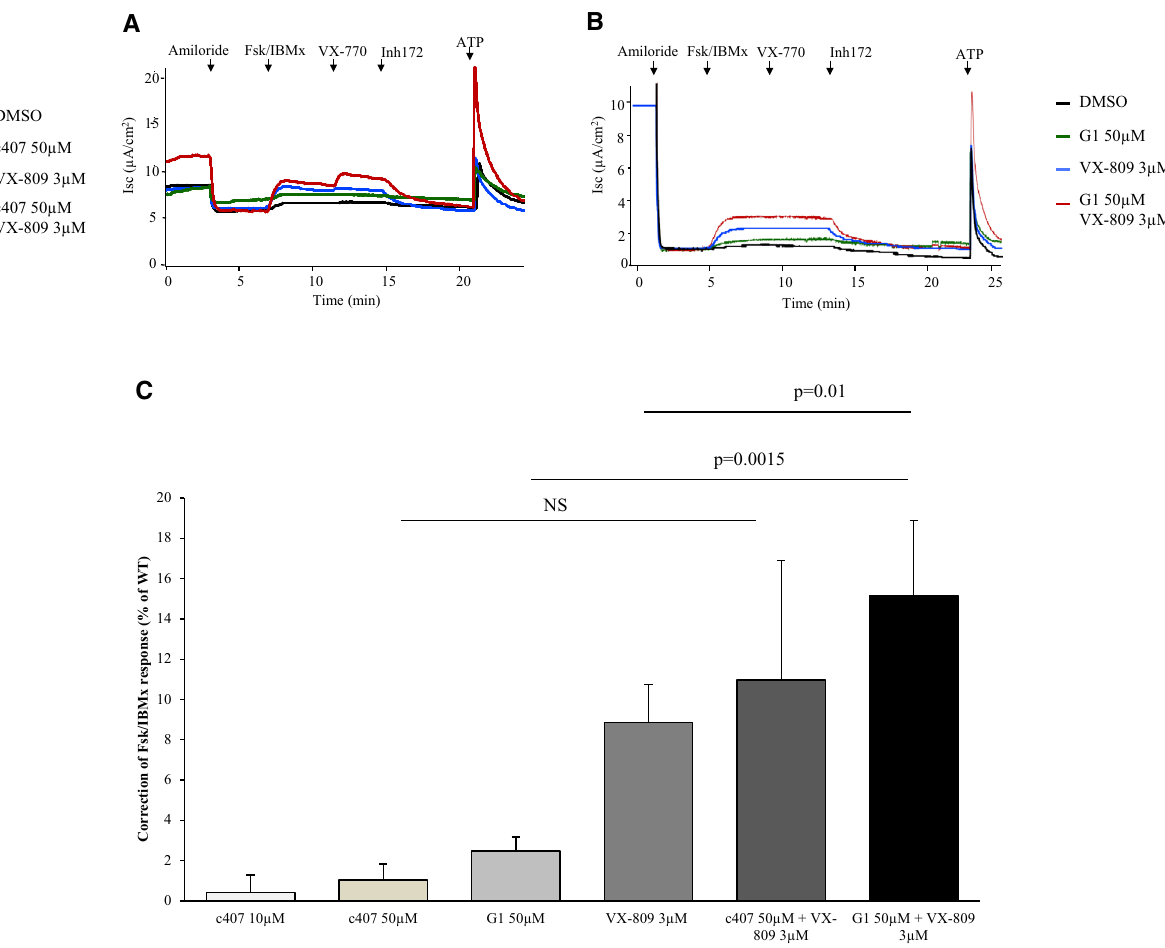
Figure 6. Stimulated correction of CFTR-dependent Cl − secretion upon c407, its extended derivative G1, VX-809 and compounds combination. Representative Ussing chamber experiments of F508del primary nasal cells treated for 48 h with DMSO, c407 50 µM, VX-809 3 µM, or their combination ( A ) and DMSO, G1 50 µM, VX-809 3 µM, or their combination ( B ). ( C ) Shows the mean (SEM) value of the current variation in response to forskolin (10 µM)/3-isobutyl-1-methylxanthine (100 µM) and VX-770 (10 µM) in the bronchial and nasal cells of F508del homozygous patients upon incubation with c407 50 µM (n = 11), G1 50 µM (n = 14), VX-809 3 µM (n = 32), VX-809 3 µM and c407 50 µM (n = 6), and VX-809 3 µM and G1 50 µM (n = 14). Isc Forsk/ VX-770 correction is calculated using the following formula: (ΔIscForsk/VX-770_corrector—ΔIscForsk/ VX-770_vehicule) divided by the mean ΔIscForsk/VX-770_vehicule, and is expressed as a percentage of WT response. WT response was previously established as the current variation in response to forskolin (10 µM)/3- isobutyl-1-methylxanthine (100 µM) and VX-770 (10 µM) in the nasal cells of seven healthy control patients incubated with Ringer for 48 h. Post hoc wilcoxon statistics are shown for G1, VX-809 and their combination. The comparison between c407, VX-809 and their combination is not significant ( p = 0.14; Kruskall Wallis